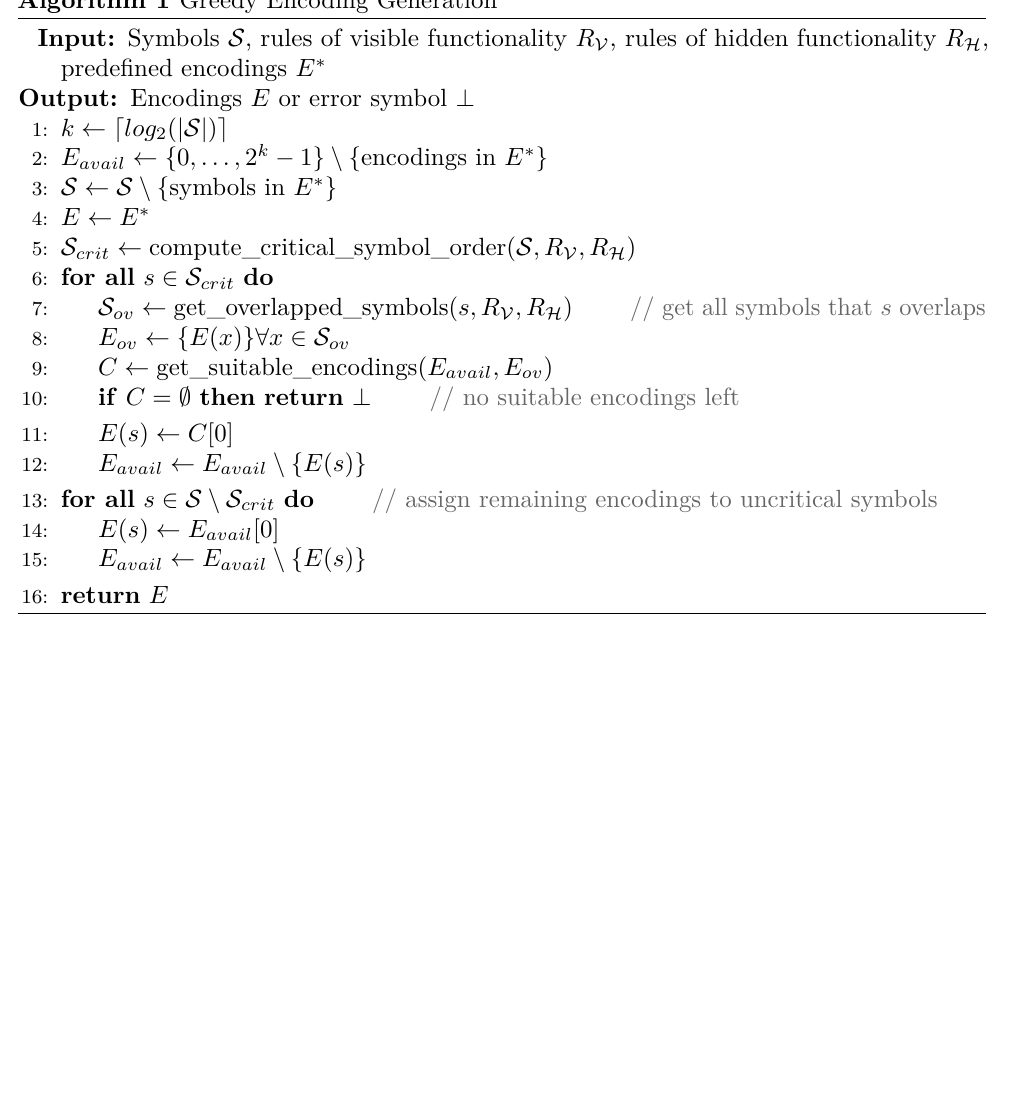
Algorithm 1 Greedy Encoding